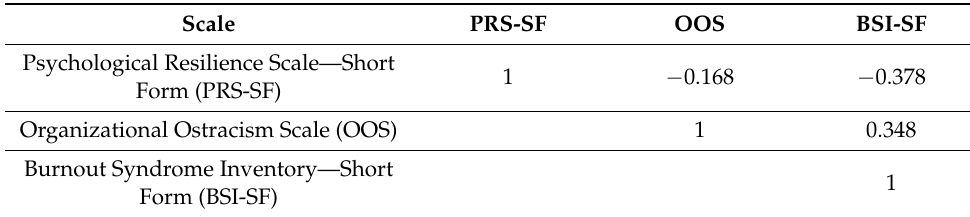
Table 2. Correlation values between the scales. Scale